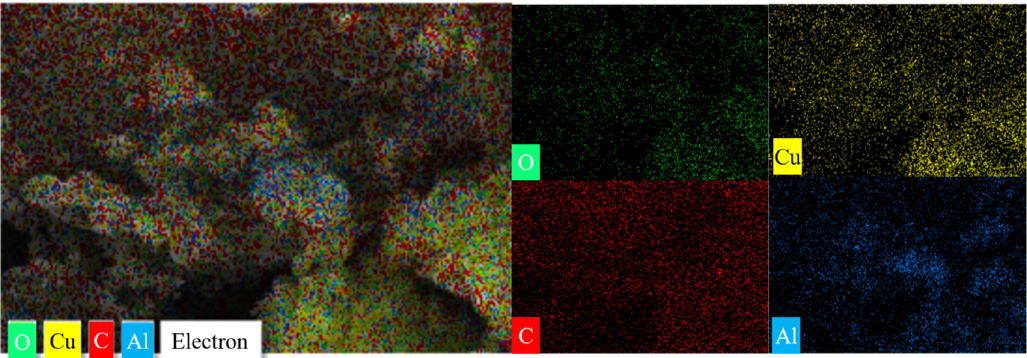
Molecules 2022 , 27 , 7614 Figure 3. EDS images of Al–CuO/GO with a CuO:Al ratio of 1.5:1. Figure 3. EDS images of Al–CuO/GO with a CuO:Al ratio of 1.5:1.